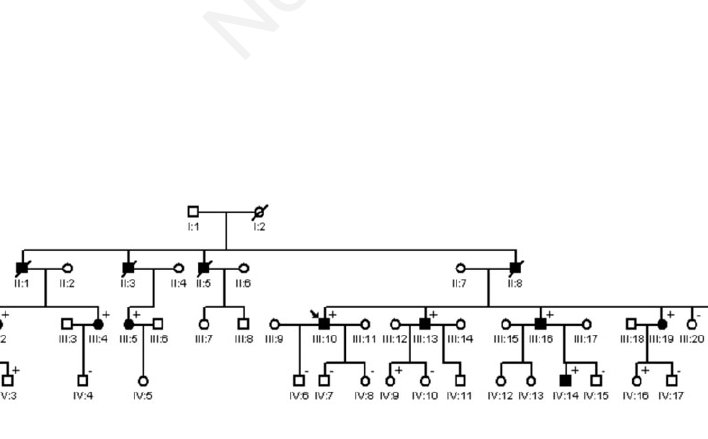
Figure 1. Pedigree of the family affected with the Glu460Asp LMNA mutation. Circles represent women; squares men, black-filled symbols represent clinically affected; plus sign, presence of the Glu460Asp LMNA mutation; minus sign, absence of the mutation.